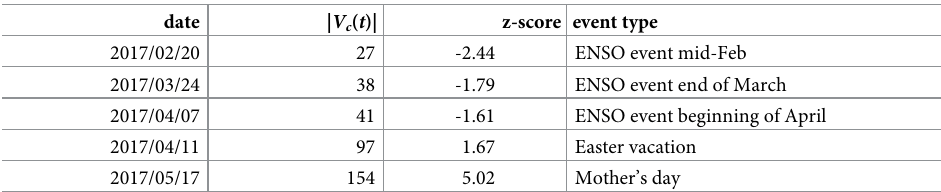
Table 1. Standard score of core size | V c ( t )| at various event times.